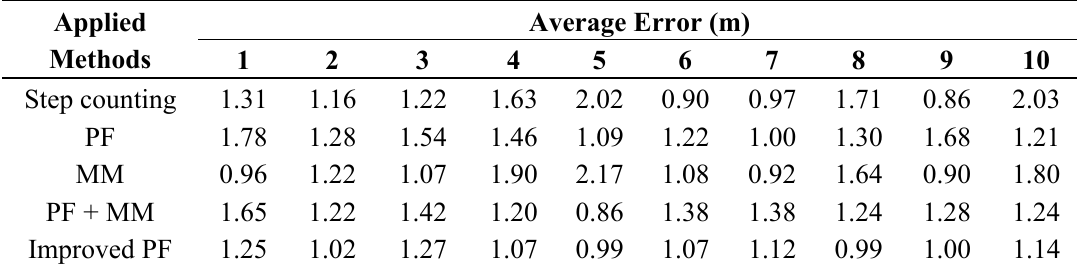
Table 3. Average error for each trial (map 1, route 1).